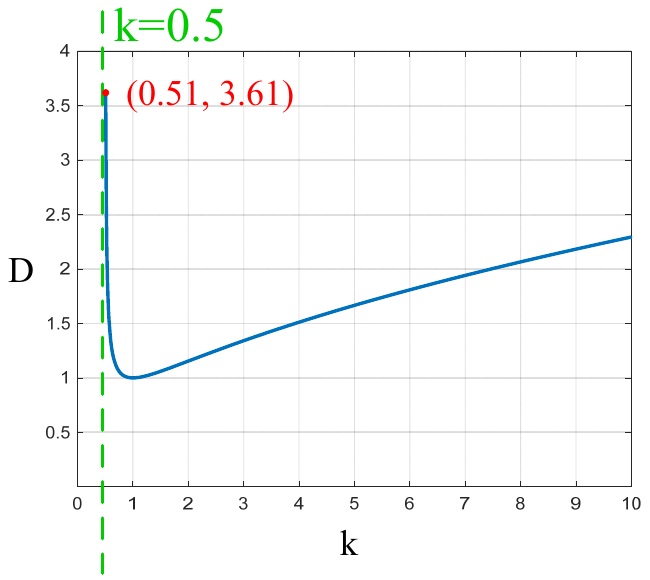
Figure 6. The ratio of the boundary output power for losing ZVS at different values of k